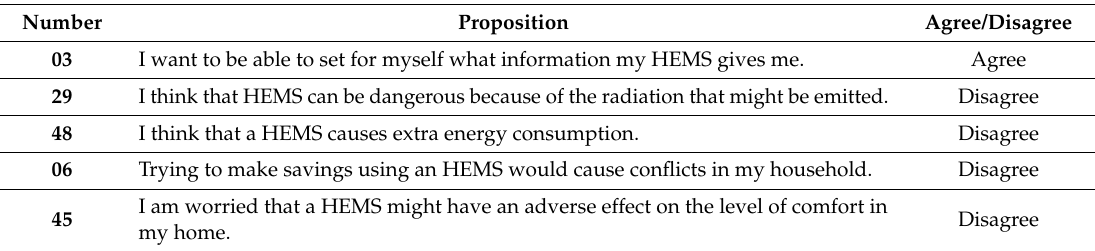
Table 3. Propositions for which a consensus exists among respondents.